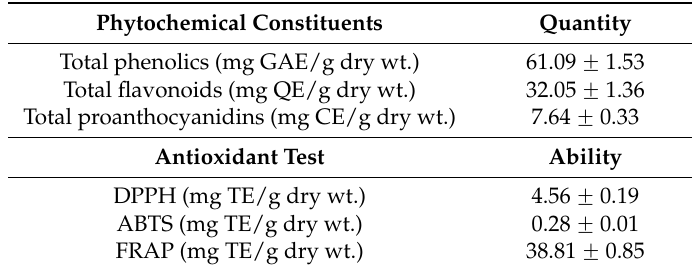
Table 1. Phytochemical constituents and in vitro antioxidant abilities of